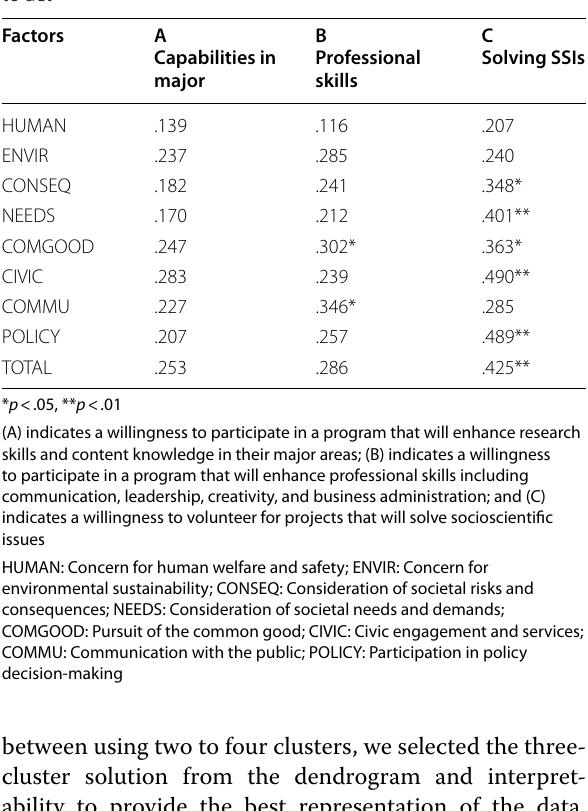
Table 4 Correlation between VSRoSE post‑scores and